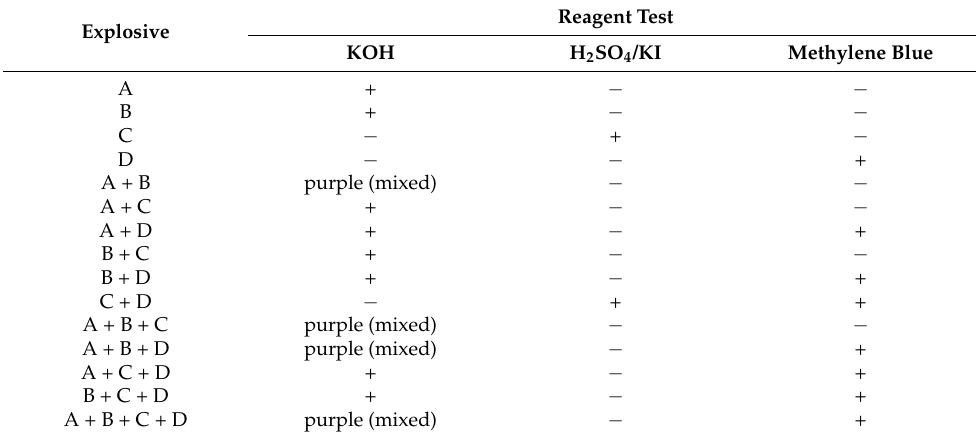
Table 4. Specificity of single explosives and multiple combinations of explosives to